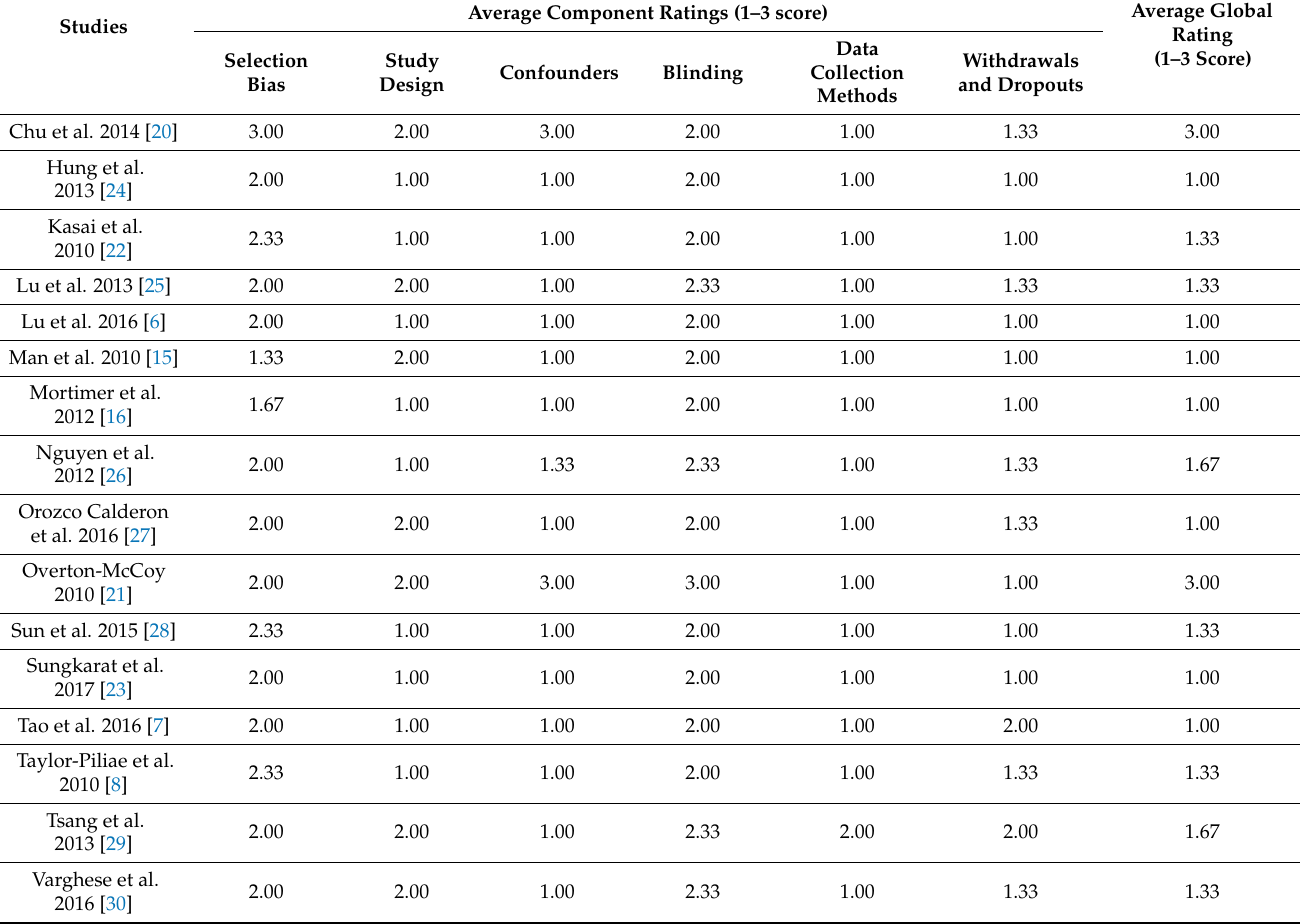
Table 2. Summary of methodological quality assessment of the included Tai Chi